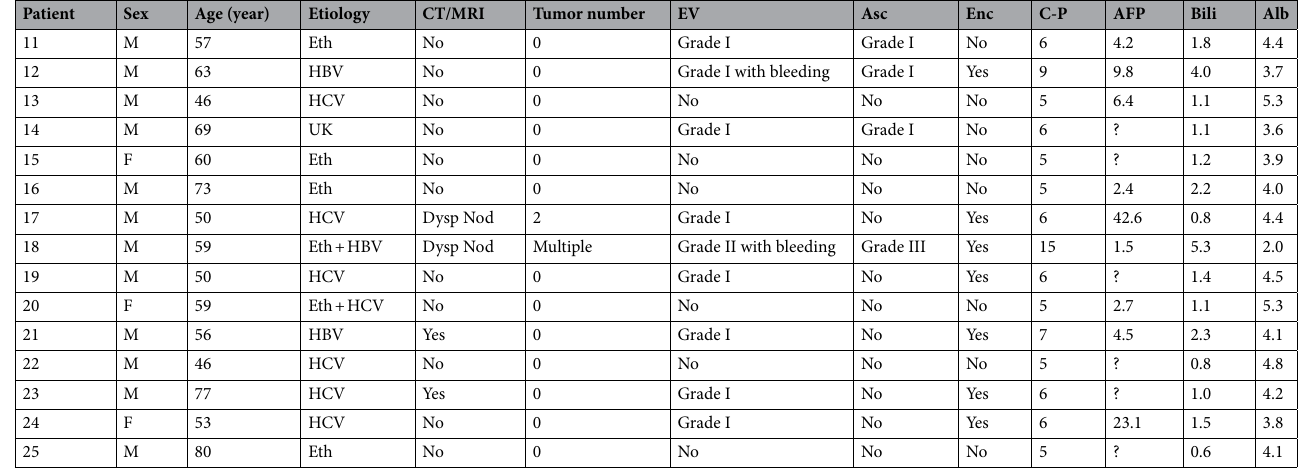
Table 2. Cirrhosis patient details. For abbreviations, see Table 1.